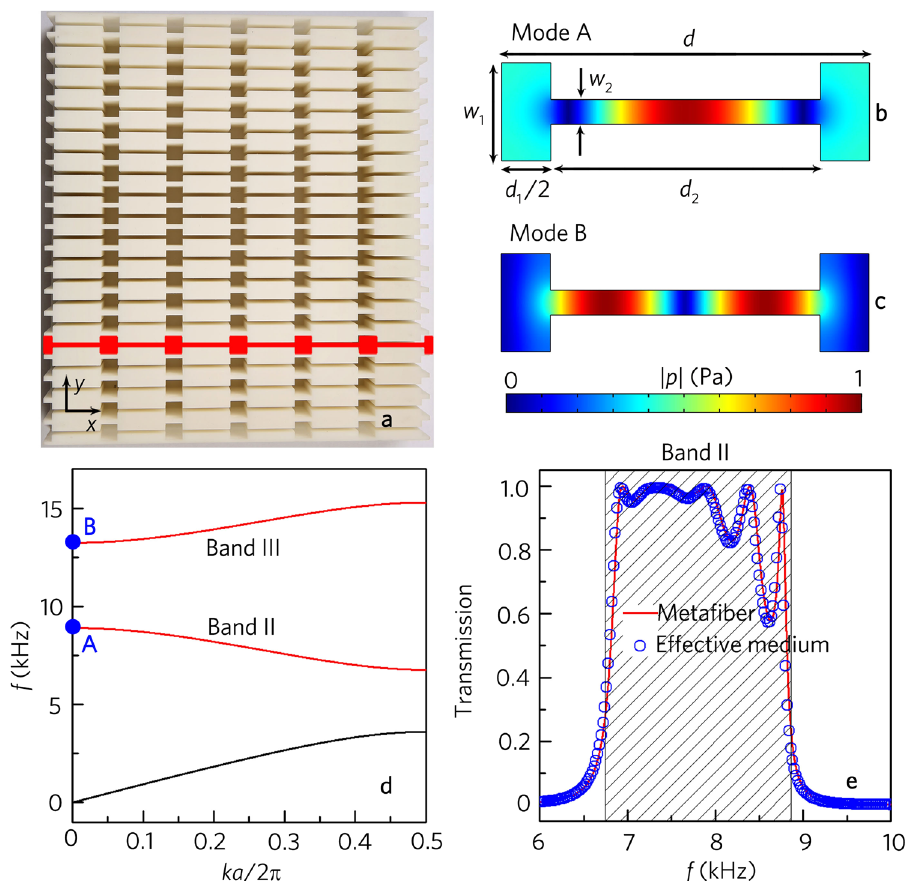
Figure 1. Geometry structure and mode analysis of acoustic metafiber. ( a ) Photograph of an acoustic metafiber bundle composed of twenty metafibers which is fabricated with photosensitive resins by means of 3D printing. The cover sheet is removed to view its structures, and the red illustration refers to a single acoustic metafiber. Simulated pressure eigenfunctions of a unit cell in the acoustic metafiber at k = 0. ( b ) Mode A, located at 8902 Hz. ( c ) Mode B, located at 13233 Hz. ( d ) Band structure of the acoustic metafiber, where the red lines represent bands II and III. Blue dots mark the eigenfrequencies shown in ( b , c) . ( e ) Simulated transmission spectrum of the acoustic metafiber and that of the effective medium theoretically calculated by the transfer matrix method. Shaded region in e represent the band II of the acoustic